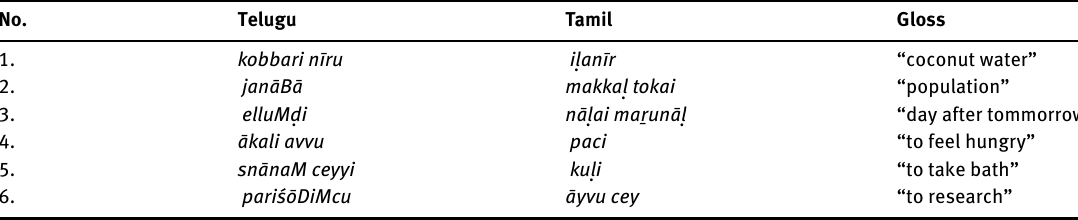
Table 3: Example for Conflational Divergence in Telugu and